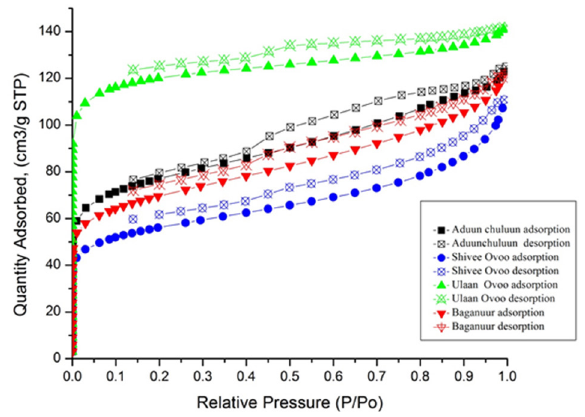
Fig. 1. Isotherm linear plot of